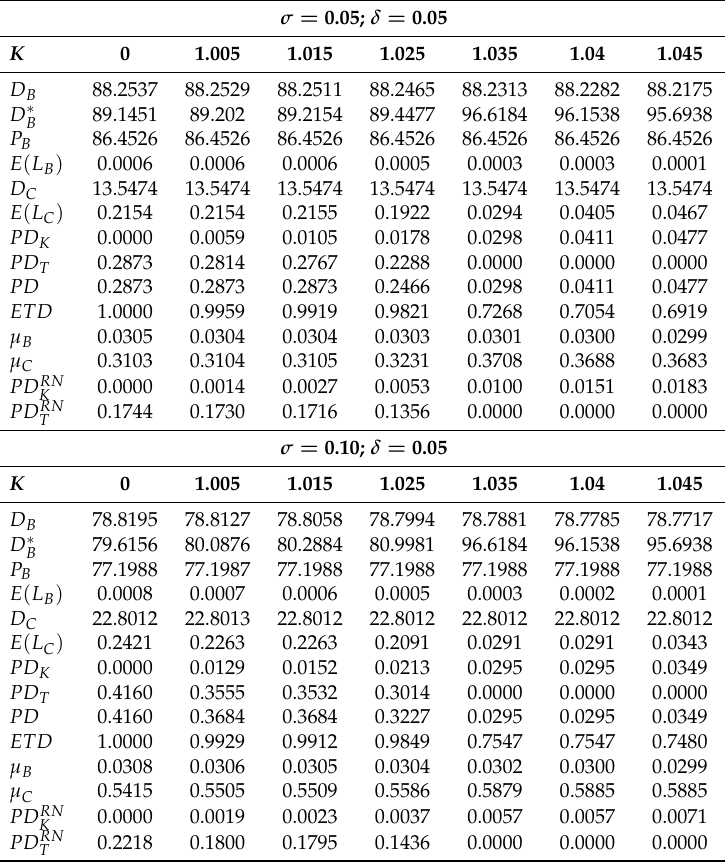
Table 6. SIV outcomes when risk control K is varied. Volatility takes two values σ = { 0.05,0.10 } and the price of debt is fixed across all cases to the price of debt when K = 0, and D B = 0.99 D ∗ . Under the B physical measure, we have asset returns µ = { 0.05,0.10 } , respectively, for the two values of volatility. σ = 0.05; δ =